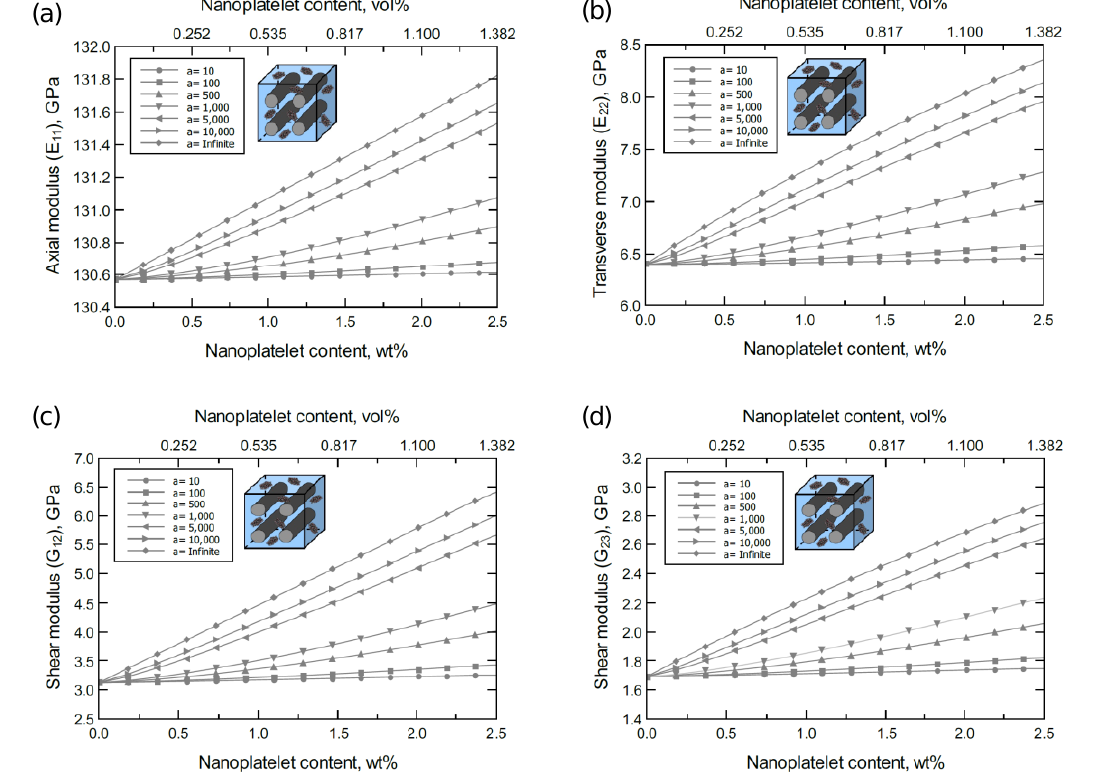
Figure 5. Predicted elastic and shear moduli for a unidirectional CF/4GNP/epoxy for various nanoplatelet content and aspect ratio values; ( a ) axial elastic modulus 𝐸 11 , ( b ) transverse elastic modulus 𝐸 22 , ( c ) shear modulus 𝐺 12 , ( d ) shear modulus 𝐺 23 . The volume fraction of CF is 56%.